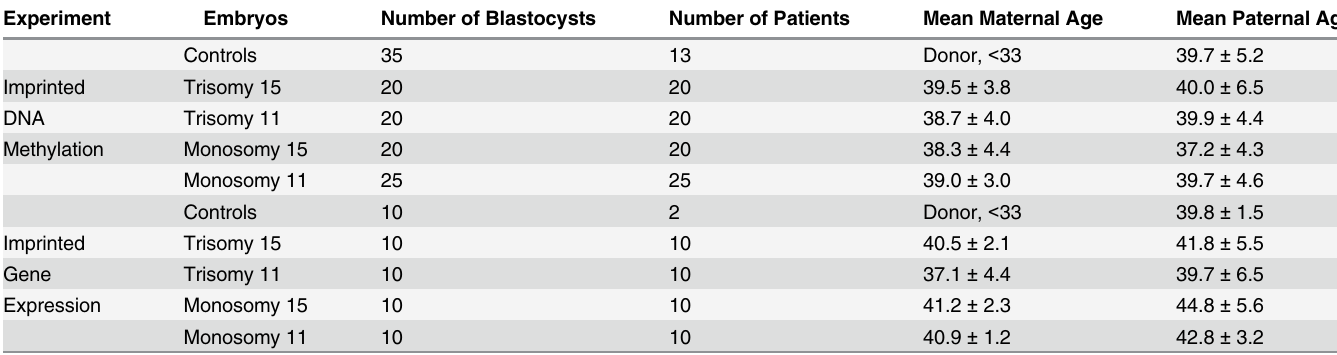
Table 1. Summary of blastocysts divided among experimental